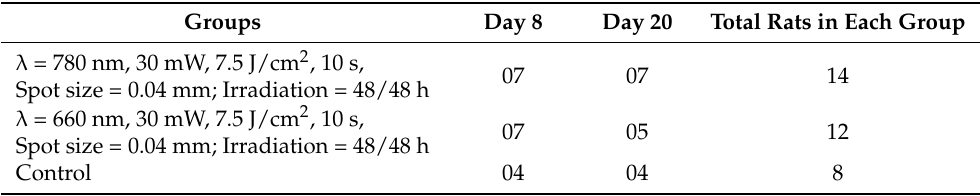
Table 2. Distribution of animals in the experimental groups, according to the days of clinical evalua- tion and description of irradiation parameters. Groups Day 8 Day 20 Total Rats in Each